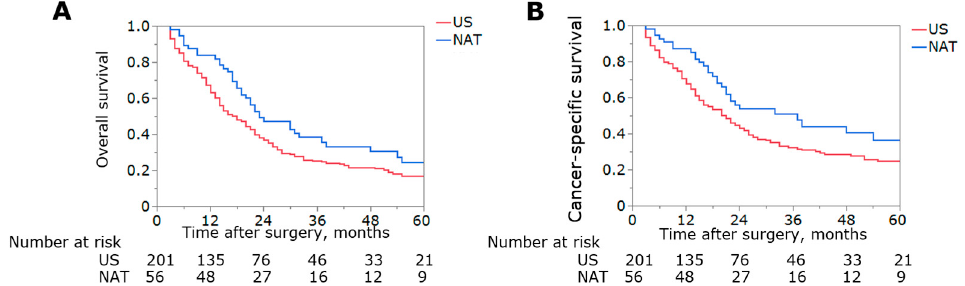
Figure 4. Kaplan–Meier curves depicting overall ( A ) and cancer-specific survival ( B ) stratified by use of NAT among patients with stages III/IVA of the disease.